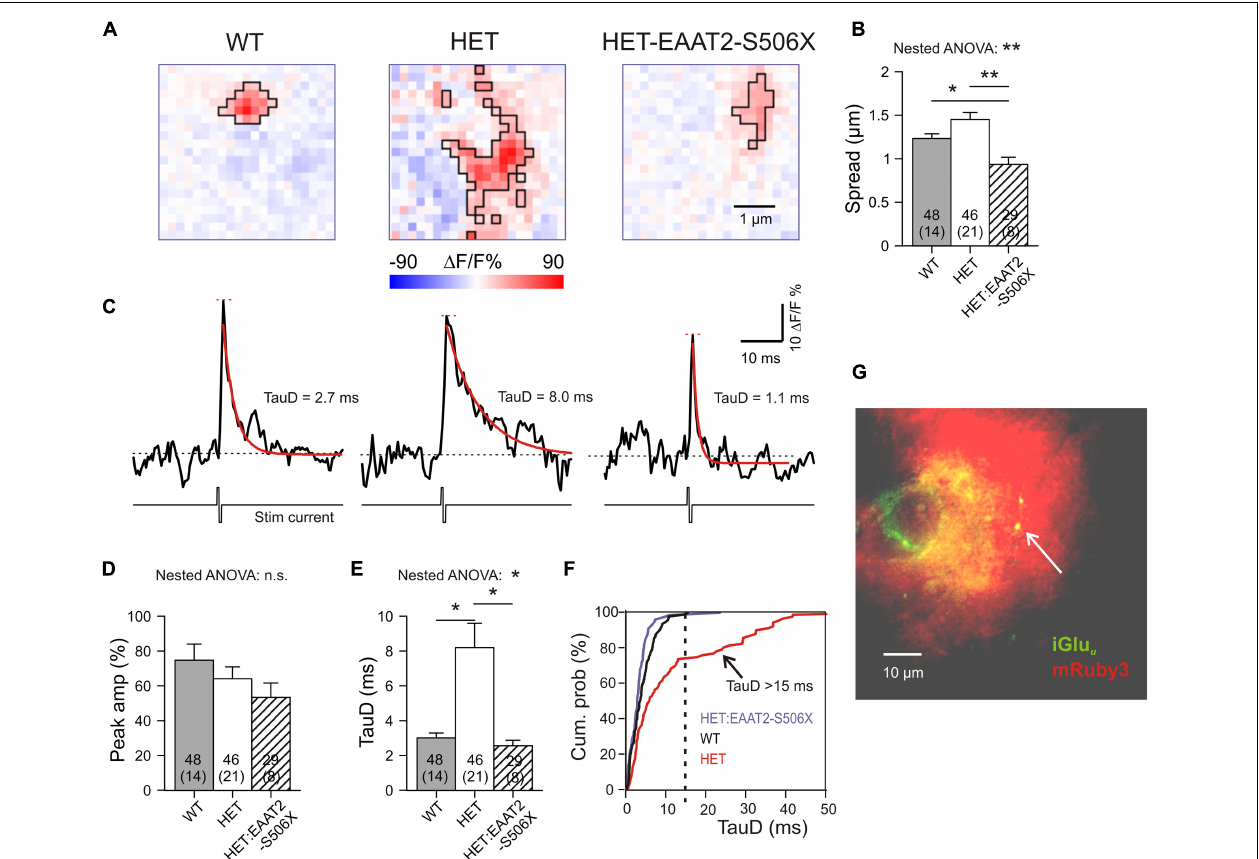
FIGURE 6 | Single synapse glutamate clearance in the striatum after expression of EAAT2-S506X. (A) Representative examples from iGlu u imaging of single corticostriatal synaptic terminals in slices from WT, HET, and treated HET. Bilateral intracranial injections of HET with EAAT2-S506X. The selected images were acquired at the response peak to illustrate the extension of iGlu u elevation (boxed area). Pink pixels within the black boundaries are pixels where stimulation of the bouton elicited a fluorescence increase ( (cid:49) F ) to values larger than the resting level prior to stimulation ( F ). (B) Glutamate spread at the ROI peak of the glutamate elevation (see Section “Materials and Methods” for definition of the parameter “Spread”). (C) iGlu u transients for the examples shown in (A) . Recordings before and after electrical stimulation of the given bouton in the presence of TTX. The traces represent the mean fluorescence intensity calculated from all suprathreshold pixels in the ROI. Red curves: Monoexponential functions fitted to the iGluu traces. In black – respective time constants of decay (TauD). (D,E) Quantification of results obtained from the pixel with the highest elevation of iGlu u fluorescence. (F) Cumulative probability plot to illustrate the absence of TauD values > 15 ms in WT and in EAAT2-S506X-treated HET. TauD values > 15 ms identify pathological synapses in HET. (G) Only synapses in the immediate vicinity of transduced astrocytes were included, as confirmed by the location of the tested iGluu-expressing varicosity on the territory of mRuby-positive astrocytes (arrowhead). * p < 0.05, ** p < 0.05, n.s., not